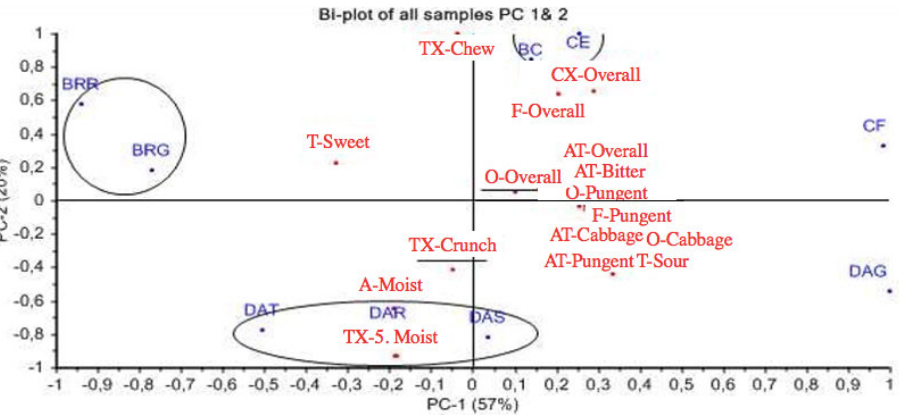
Figure 8. Bi ‐ plot of all samples PC1 and PC2. Abbreviations of samples: BRG: Beetroot grated, BRR: